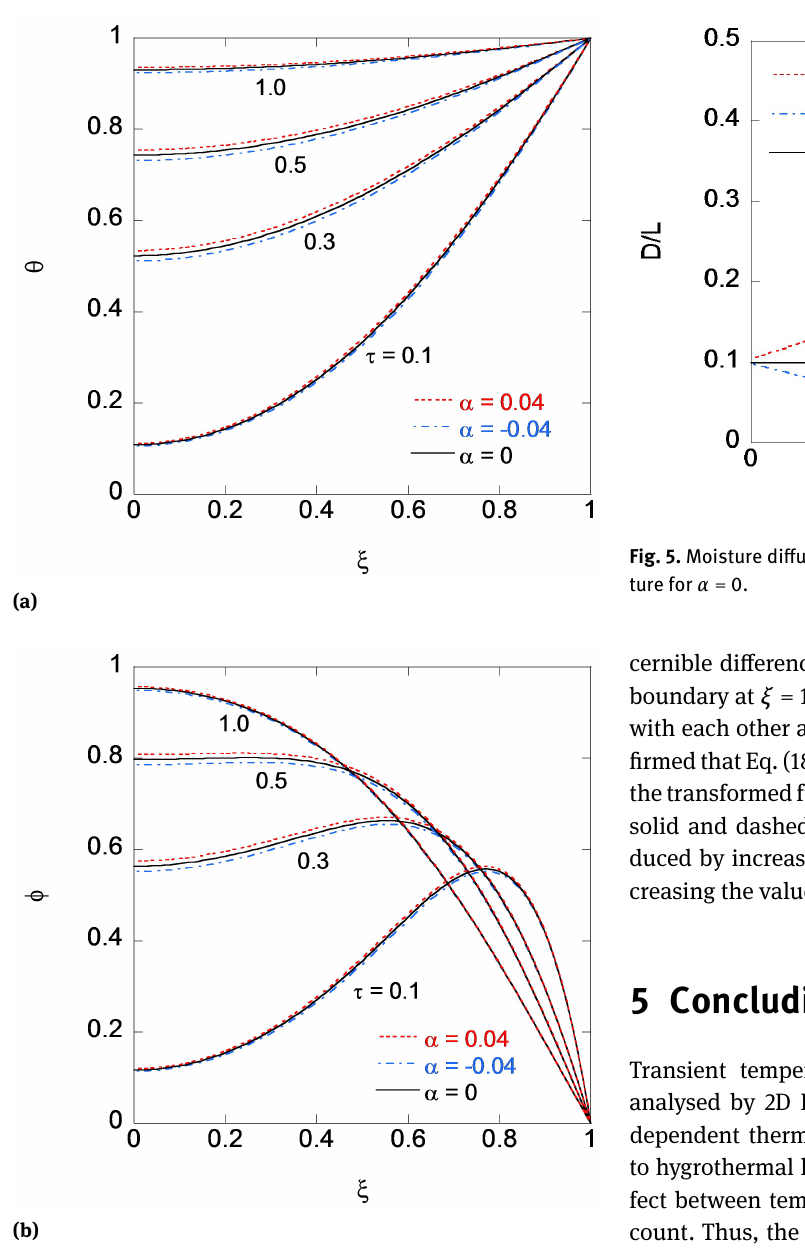
Fig. 4. (A) Temperature and (B) moisture profiles in slab with differ- ent α -values for r = 10 and ε = 0.